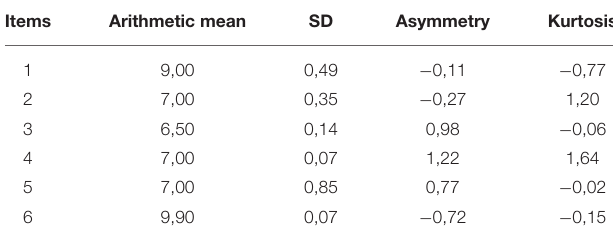
TABLE 2 | Descriptive statistical analysis of the Academic Activity Scale in Study 1 with distance